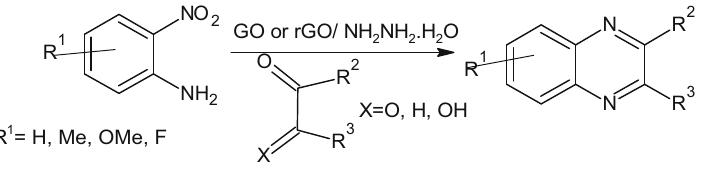
Scheme 12: GO/rGO catalyzed synthesis of quinoxalines from 2 -